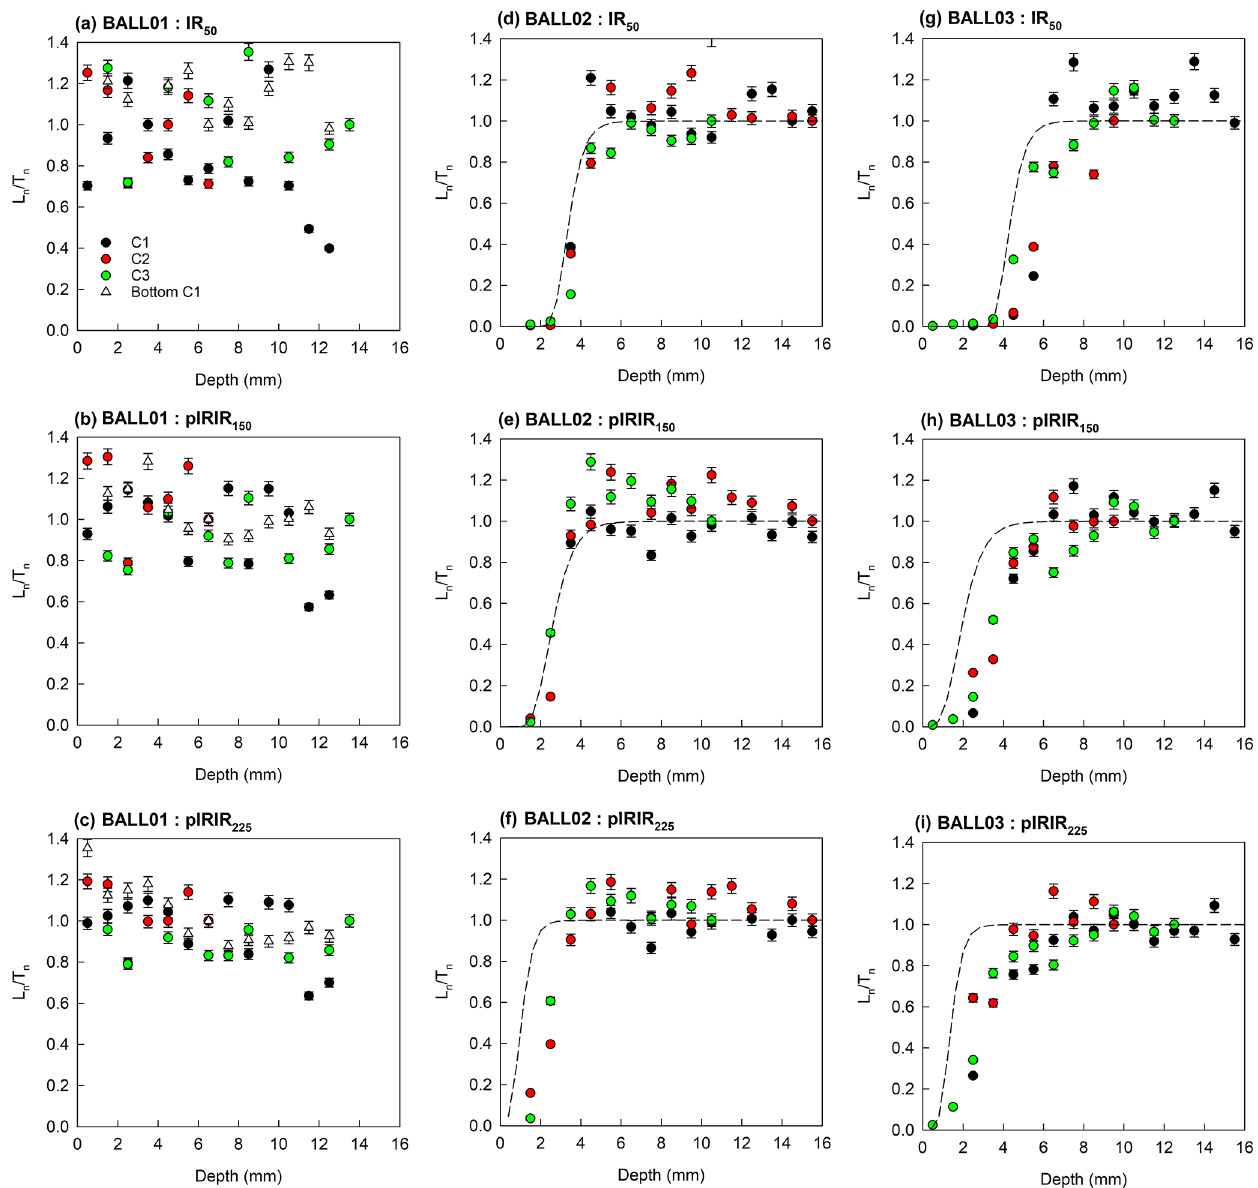
Figure 5. IRSL depth profiles for each of the replicate cores analysed using the IR 50 (a, d, g) , pIRIR 150 (b, e, h) and pIRIR 225 (c, f, i) signals for samples BALL01 (a–c) , BALL02 (d–f) and BALL03 (g–i) . All of the raw L n /T n data (Tables S5–S7) were normalised individually for each core, and subsequent analysis uses the data in this format. The dashed line is the best fit of the inferred erosion model for each luminescence depth profile derived from the probability distributions shown in Fig. 7, where erosion rates are included in Table